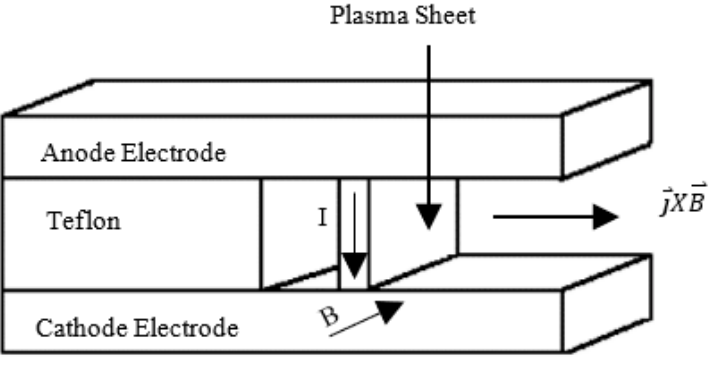
Figure 3. Rectangular PPT.